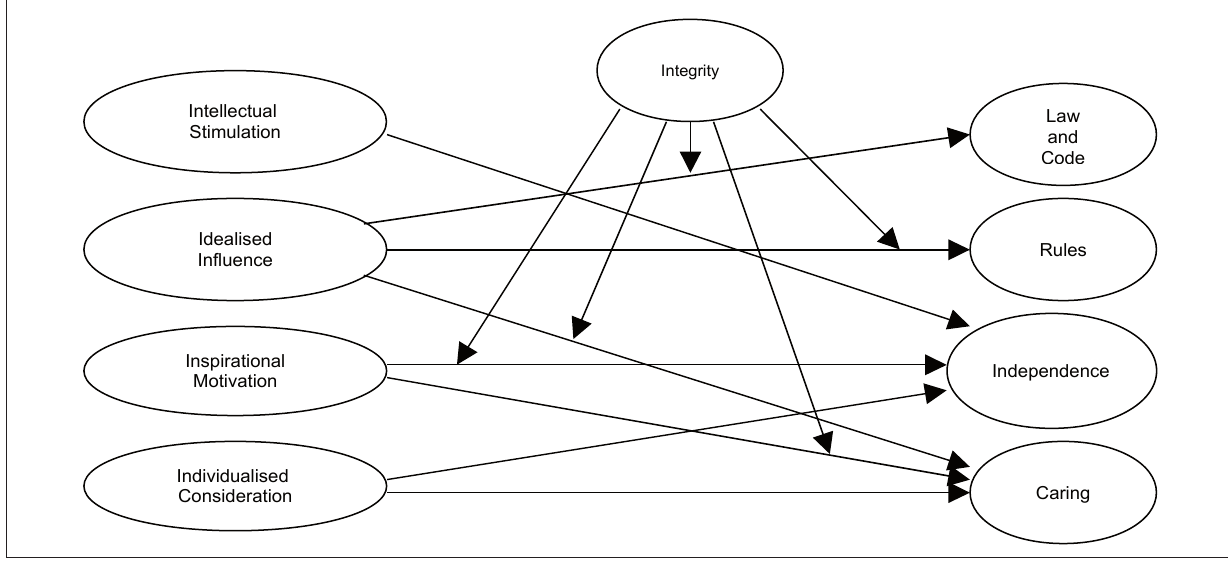
FIGURE 1 A conceptual model of the relationships between transformational leadership, integrity and the dimensions of an ethical